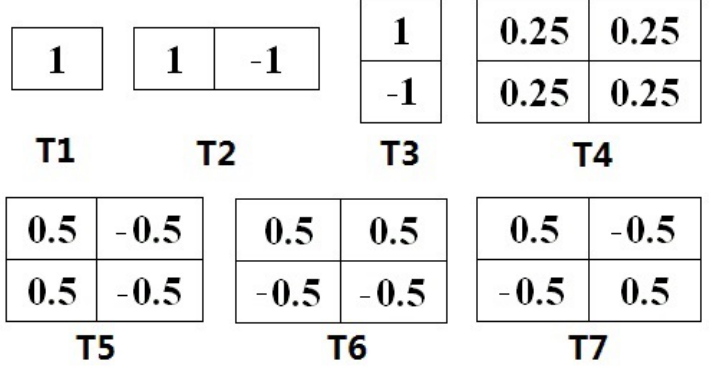
Figure 3. Seven Haar-like